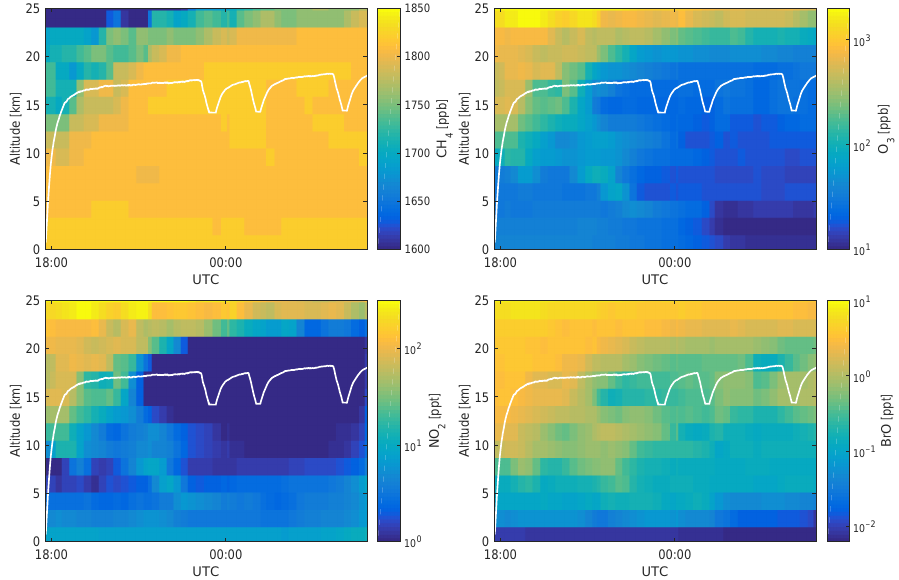
Figure 6. Tomcat/Slimcat simulation of mixing ratio curtains (on a log scale) of CH 4 (upper left panel), O 3 (upper right panel), NO 2 (lower left panel), and BrO (lower right panel) together with the flight trajectory for the sunlit part of SF3-2013 (14 February 2013). For better visibility, the simulated mixing ratios are shown for the altitude range 0–25km, although the Tomcat/Slimcat simulations cover 36 unevenly spaced levels between 0 and 63km